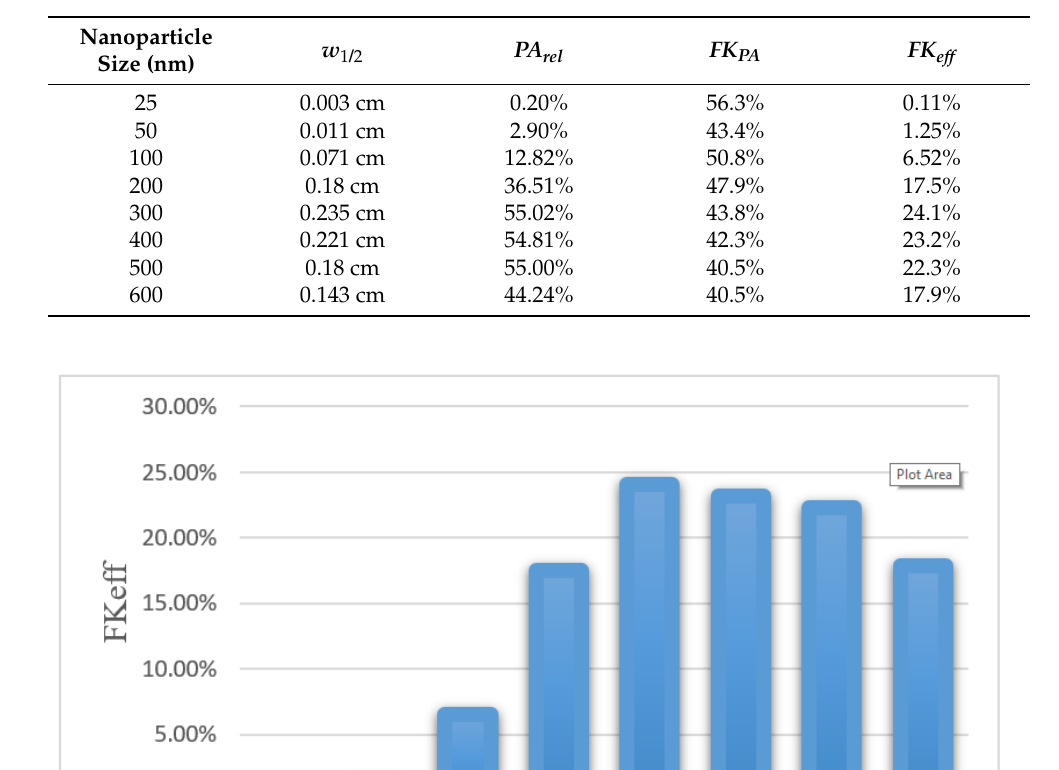
Table 6. Comparison of treatment efficacy parameters for different sizes of MNPs after 60 min of treatment.